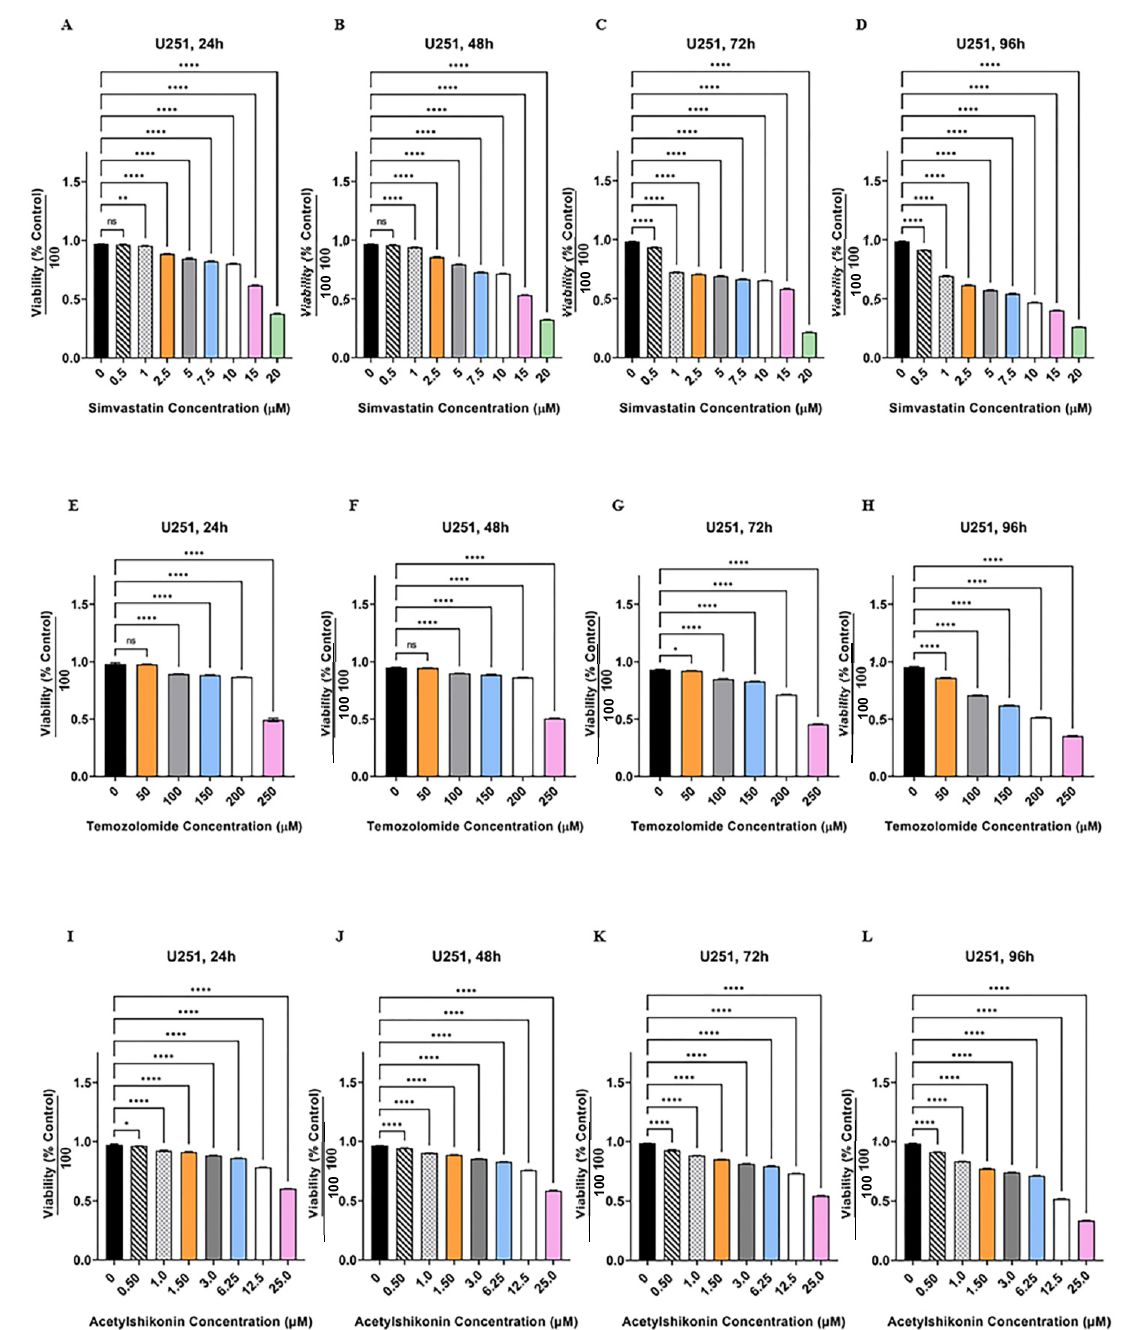
Figure 1. Simvastatin, temozolomide and acetylshikonin induce cell death in human glioblastoma cells. U251 cells were treated with different concentrations of Simva (0.5–20 µ M, A – D ), TMZ (50–100 µ M, E – H ), and ASH (0.5–25 µ M, I – L ), at four time points (24, 48, 72 and 96 h). The cytotoxicity of each treatment was measured using an MTT assay. The cell viability was measured (ns = non-significant; * = p < 0.05; ** = p < 0.01; **** = p < 0.0001) and compared to the time-match vehicle control. Simva induced a significant decrease in cell viability ( p < 0.0001) for all concentrations at all time points, except 0.5 µ M at 24 and 48 h ( p > 0.05) and 1 µ M at 24 h ( p < 0.01). TMZ induced significant cell death ( p < 0.0001) for all concentrations at all time points, except 50 µ M at 24 and 48 h ( p > 0.05) and 50 µ M at 72 h ( p < 0.05). ASH induced significant cell death ( p < 0.0001) for all concentrations at all time points, except 0.5 µ M at 24 h ( p < 0.05). The represented findings are from nine replicates in three independent biological assays and are showed as the mean ±